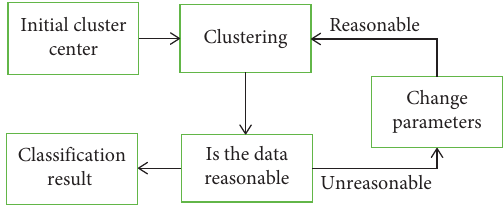
Figure 7: Technical route of dynamic clustering